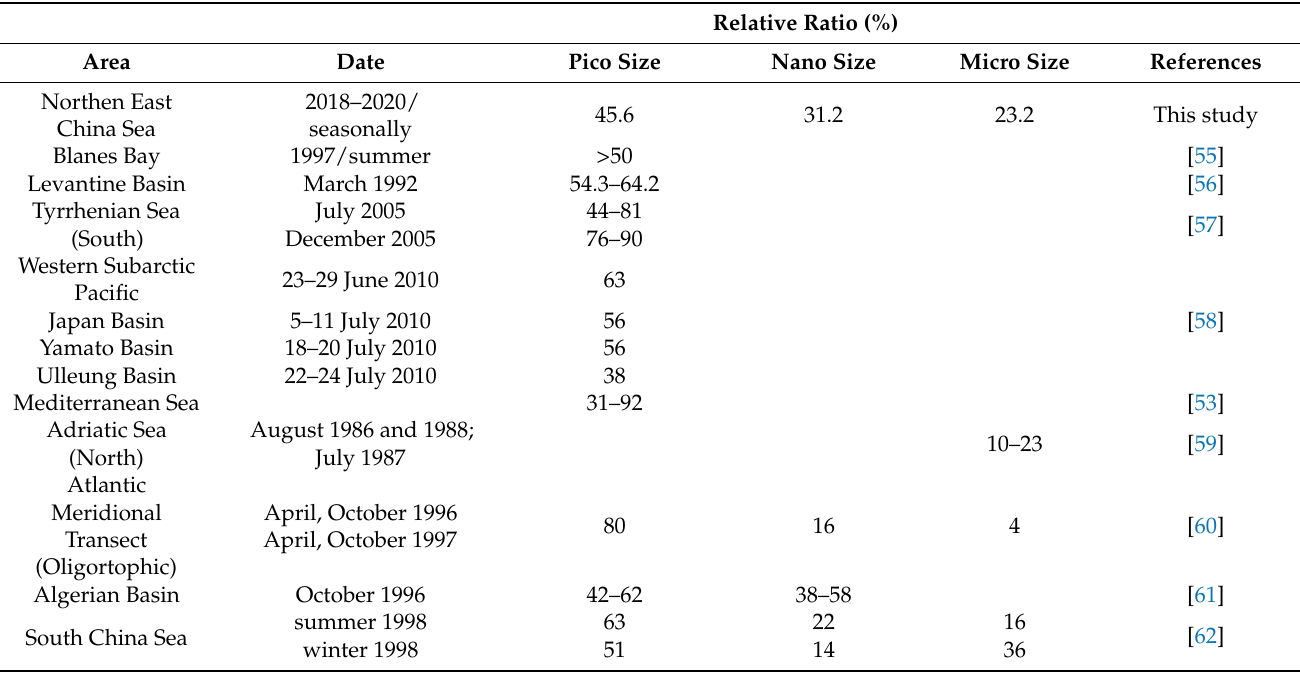
Table 5. Size fractionation of phytoplankton observed in the different coastal waters of the northern East China Sea and global